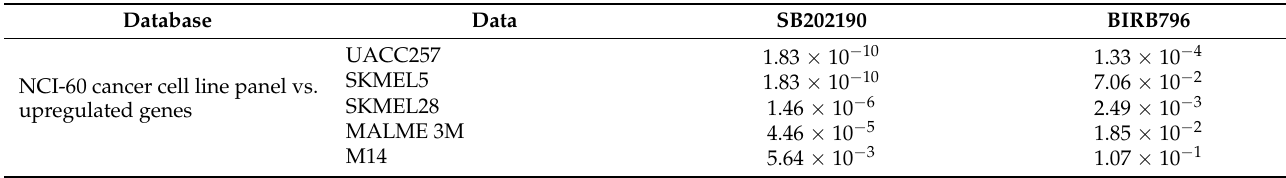
Table 3. Gene set enrichment analysis. Over-representation of gene lists from published datasets, in the differentially expressed genes detected in this study, was analysed using the Enrichr web server. Adjusted p -values.